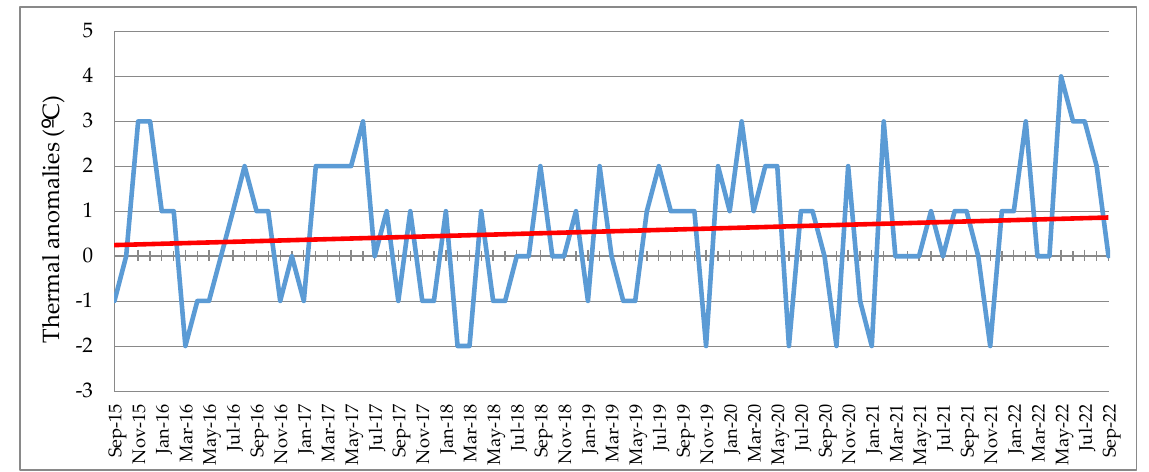
Figure 9. Thermal anomalies in the upper Gállego River basin. September 2015 – September 2022 (over 1981-2010 reference period, as determined by AEMET for these comparisons). Trend line (red). Data source and methodology: AEMET [37,38,57,58].